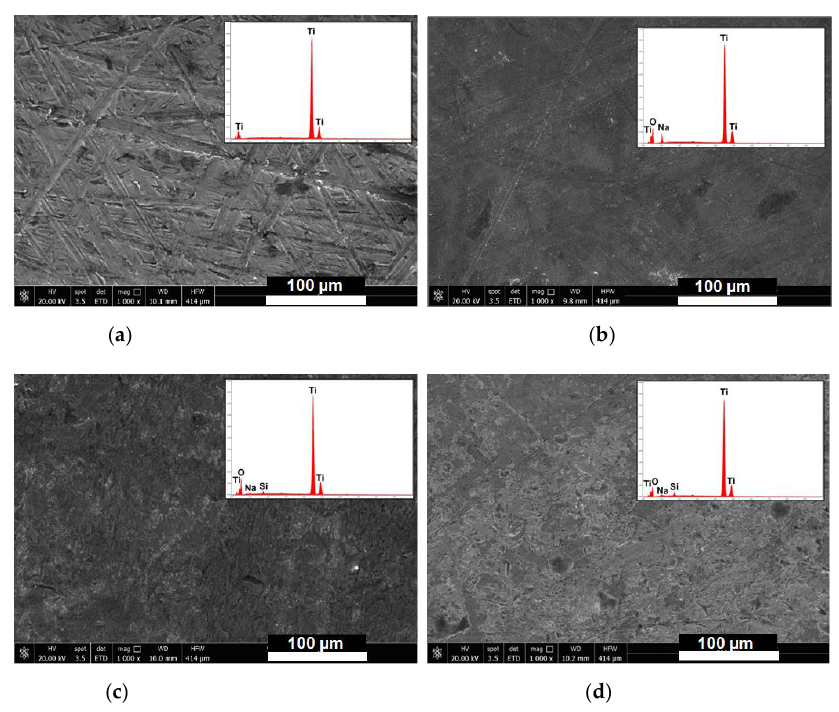
Figure 3. Representative Scanning Electron Microscopy/Energy Dispersive X-ray (SEM/EDX) analyses of ( a )Ti, ( b ) Ti-OH, ( c ) TI-APTES, and ( d ) Ti-DAPTES samples.